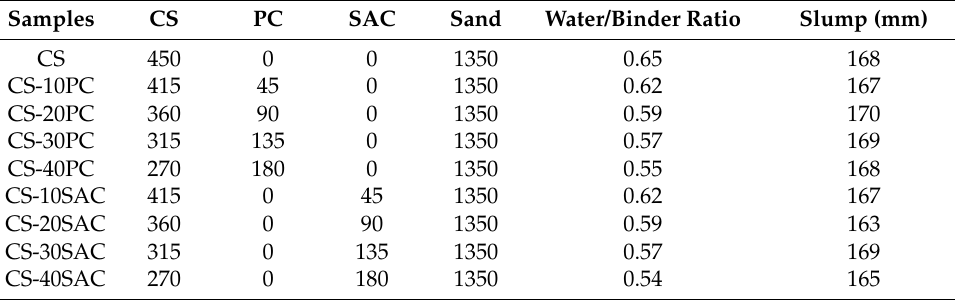
Table 2. Mix proportions (kg/m 3 ) and workability of